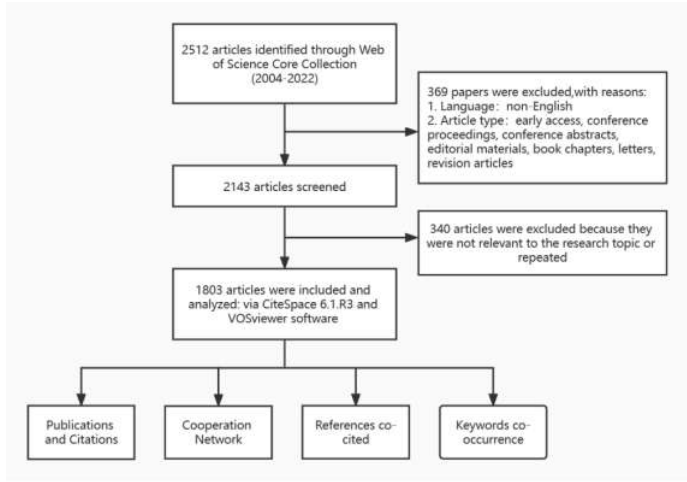
Figure 1. Literature search, screening, and analysis